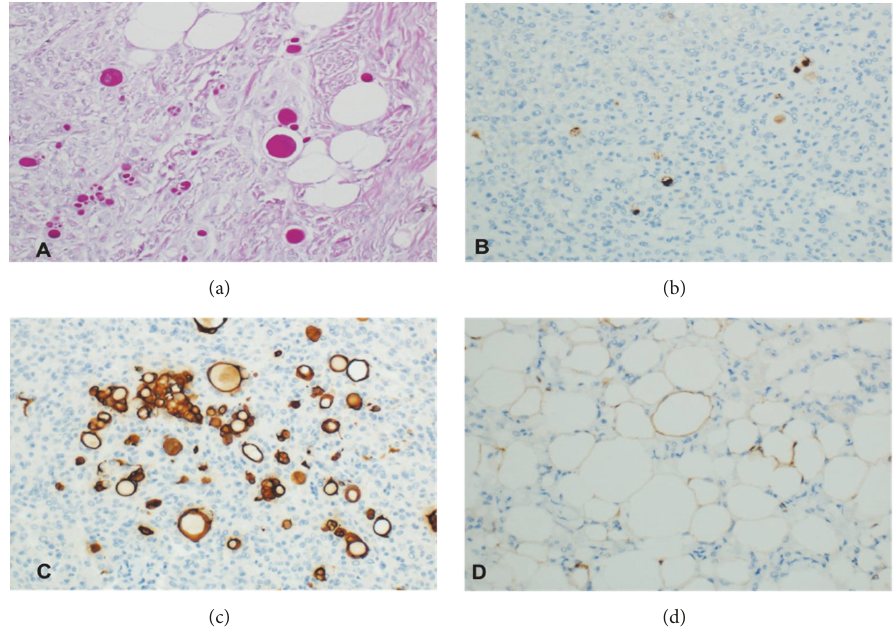
Figure 3: The secretory hyaline bodies highlighted by PAS (a) and CEA (b). Positive reaction of cytokeratin antibody of the cells surrounding the hyaline bodies (c). Mature fat cells positive for S100 (d).